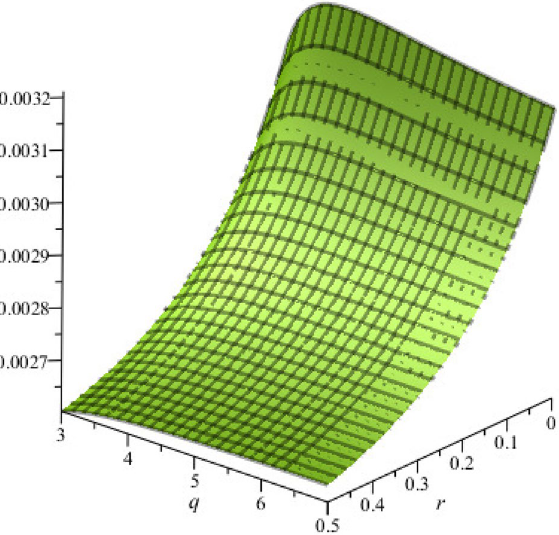
Figure 5. Influence of q and r on phase shift (Δ Q 0 ) with N hc = 0.08, N ec = 0.5, ǫ = 0.1, δ = 0.5 and σ =